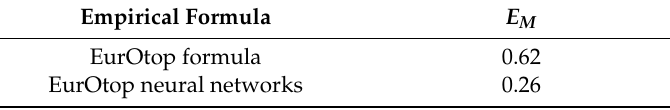
Table 3. E M between estimated and physical model values.